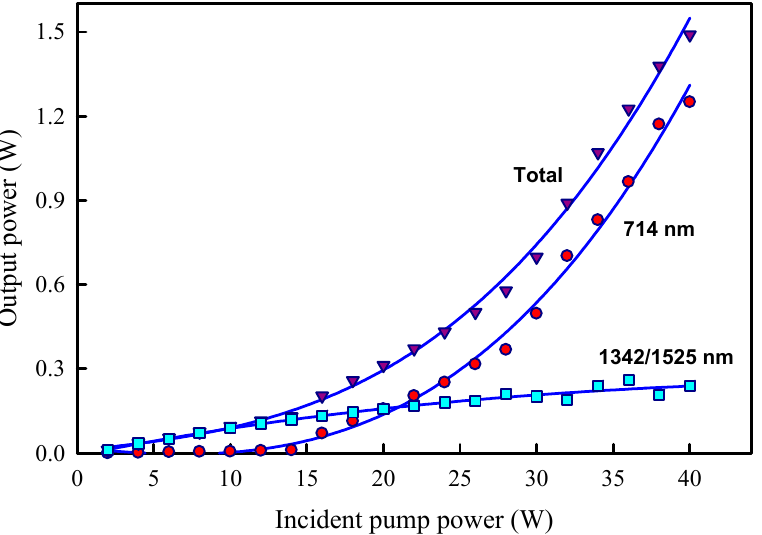
Figure 3. Experimental result for total output power, SFG output power, and fundamental and Raman output powers versus incident pump power with the cavity shown in Figure 1a.